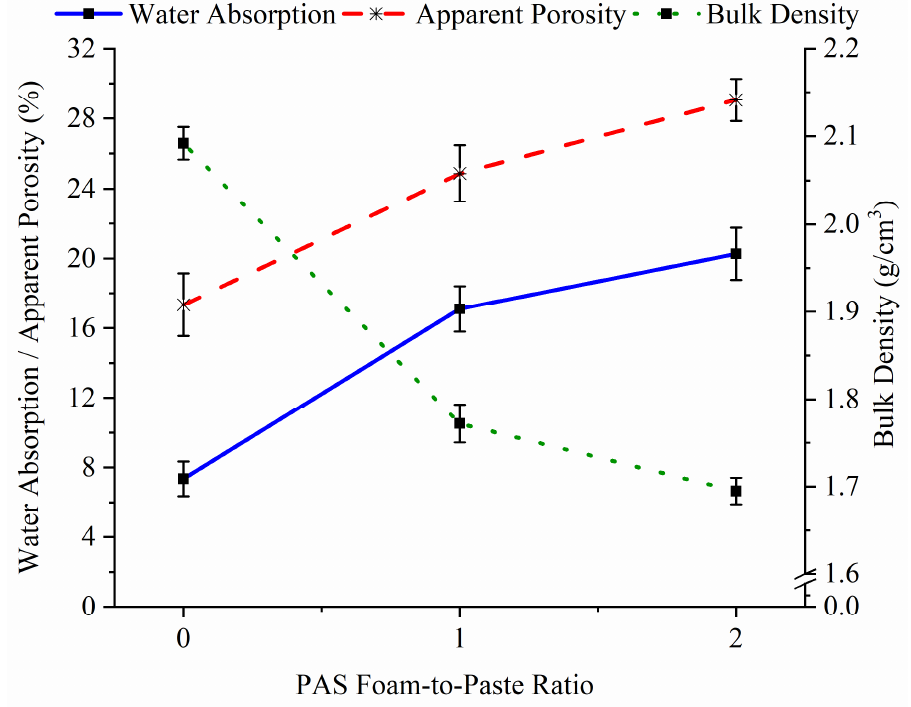
Figure 3. Bulk density, water absorption and apparent porosity of G-0, G-1 and G-2. The pore size distribution and total porosity of G-0, G-1 and G-2 are plotted in Figure 4. G-0 (Figure 4a), G-1 (Figure 4b) and G-2 (Figure 4c) were mostly made up of open pores, while minorly made up of closed pores. However, foamed geopolymer (14.81% for G-1 and 15.94% for G-2) exhibited a greater total porosity than G-0 (10.45%), supporting the bulk density and apparent porosity results (Figure 3). This was because of the large pore diameter of 500–1000 µm (~78%) present in the foamed geopolymers but absent in G-0.